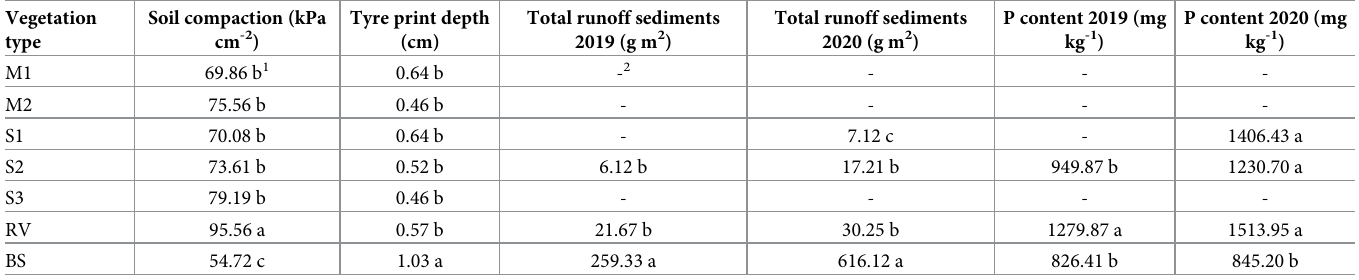
Table 6. Effects of type of vegetation (M1 = grass-legume mixture 1, M2 = grass-legume mixture 2, S1 = Schedonorus arundinaceus blend, S2 = Lolium perenne blend, S3 = Festuca rubra blend, RV = resident vegetation) and bare soil (BS) on soil compaction, tractor tyre print depth, and total runoff sediments and P content of runoff sediments in 2019 and